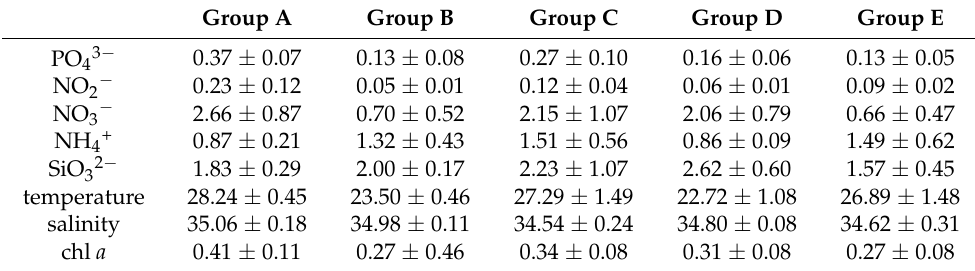
Table 3. Average ( ± standard deviations) values for nutrients ( µ mol L − 1 ), temperature ( ◦ C), salinity, and chlorophyll a ( µ g L − 1 ) for each phytoplankton community group identified by the cluster analysis in the